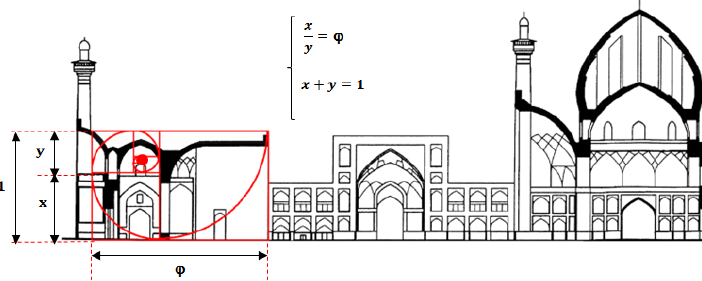
Figure 9: Adapting the smaller section with golden rectangle